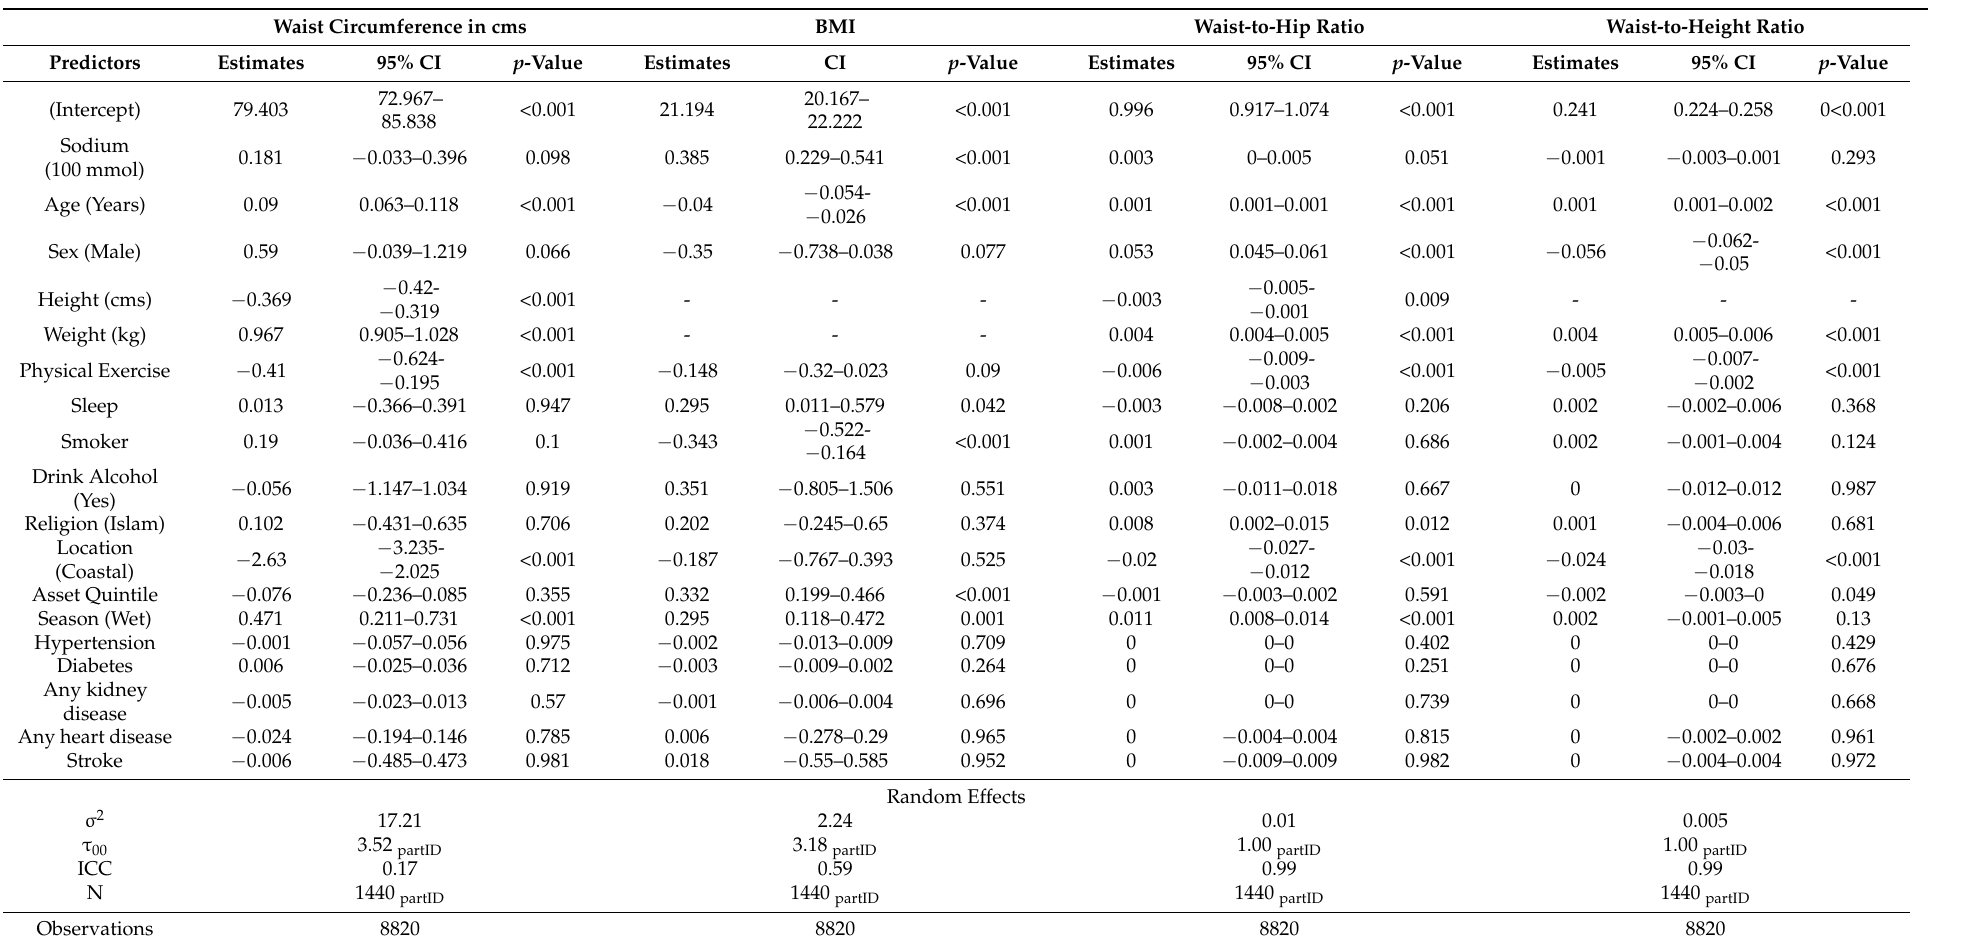
Table 10. Association between 24 h urinary sodium and 10th percentile waist circumference, BMI, waist-to-hip ratio and waist-to-height